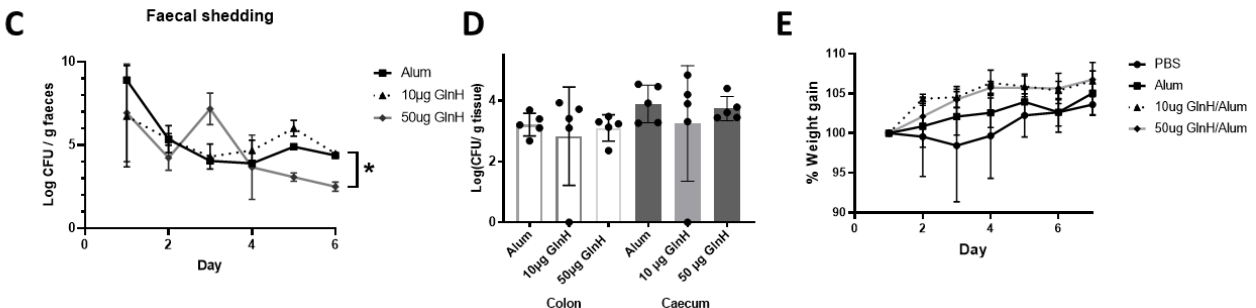
Figure 4. ( A ) Timeline of vaccination schedule, indicating days of immunisation, challenge and organ collection. Mice were immunised three times with 10 or 50 µg recombinant GlnH antigen with alum as adjuvant. ( B ) Serological analysis of responses to GlnH immunisation in mice. Sera were obtained by blood collection seven days after third immunisation dose, serially diluted and antibody titres determined by ELISA using antigen-specific antibodies and antibodies specific for mouse IgGs. Data are reported as the OD obtained at each dilution. ( C ) Faecal shedding was monitored daily to access protection conferred against E. coli O157 NCTC Nal r 6 days post-challenge. The daily E. coli O157 shed from mice faeces (pooled per cage) are represented as mean CFU ± SD of two independent faecal collections from each group. Significant differences in daily NCTC12900Nal r shed between groups were determined via two-way ANOVA Tukey’s multiple comparison test (*, p < 0.05). ( D ) Colonisation of colon (white bars) and caecum (grey bars) at day 7 post-challenge with 4 × 10 9 CFU with E. coli prototype strain NCTC 12900 Nal r ; the colon and caecum were collected from each mouse after euthanasia. Bacterial burden was determined per gram of tissue, and level of colonisation was expressed in log scale. All colonisation data are displayed as means ± SEM of results obtained per treatment group. No statistical significance was observed by analysis using a one-way ANOVA with Sidak’s multiple comparison test between immunised and non-immunized groups. ( E ) Weight gain in immunised mice relative to control mice over 7 days post challenge. Data are normalised relative to individual mouse weight.